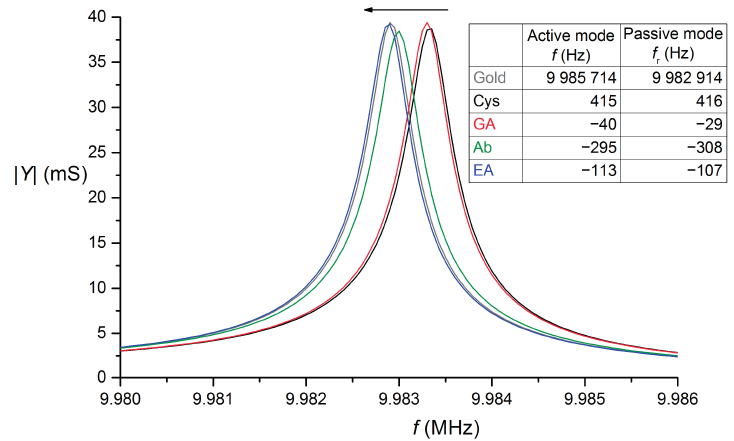
Figure 3. Impedance characteristics of quartz crystal after individual immobilization